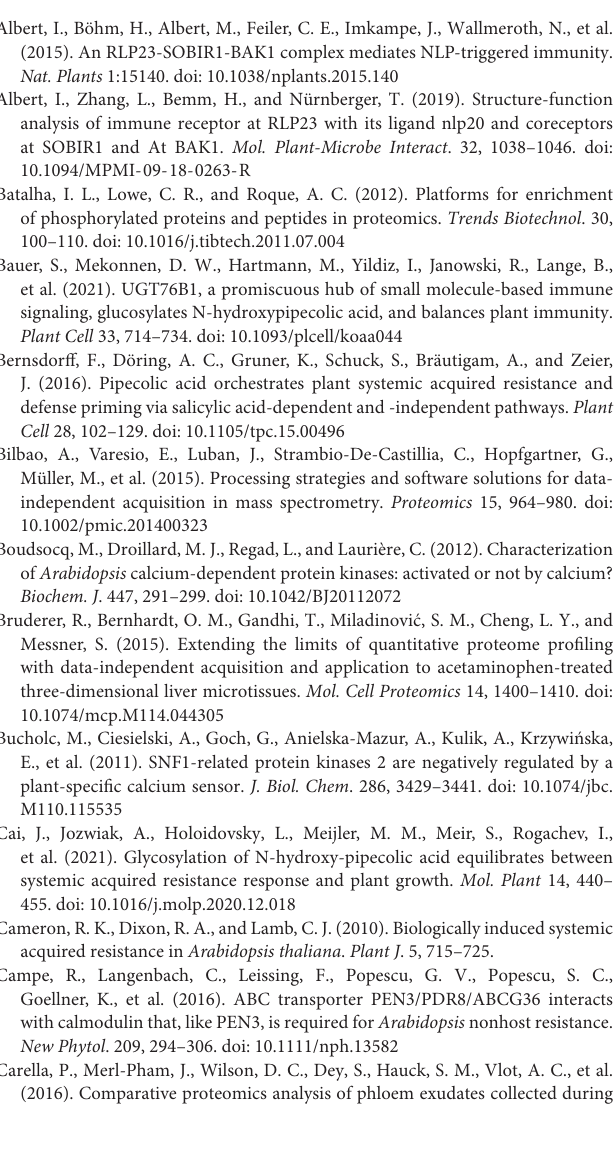
Supplementary Table 2 | Total phosphoproteins identified in this study. Supplementary Table 3 | Identified proteins containing Tyr phosphorylation. Supplementary Table 4 | Proteins containing two or more significantly changed phosphopeptides.